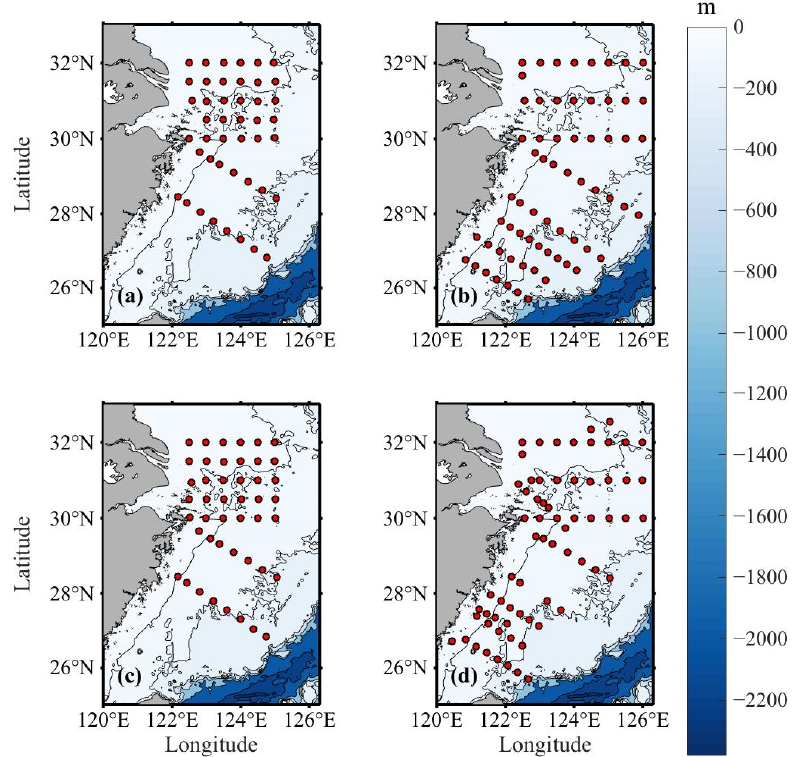
Figure 2. Processed cruises station distributions in the ECS shelf. The red dots show the locations of stations, and the black lines present the − 50 m, − 100 m, − 200 m, − 500 m, − 1000 m, and − 2000 m isobaths. ( a ) Summer (June) 2010; ( b ) Summer (June) 2011; ( c ) Autumn (November) 2010; and ( d ) Autumn (October) 2011. Table 1. The number of the stations and observations included in the paper. Period Stations